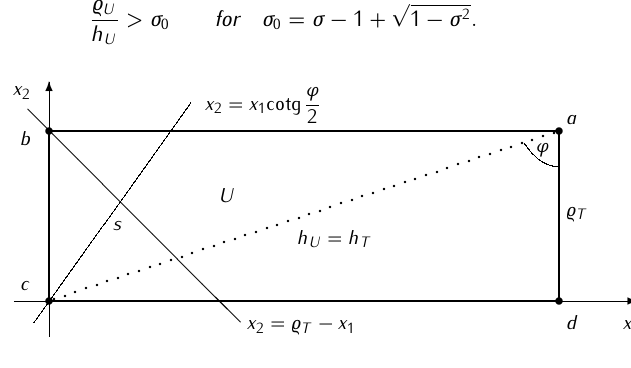
Figure 1. Regularity of the triangle